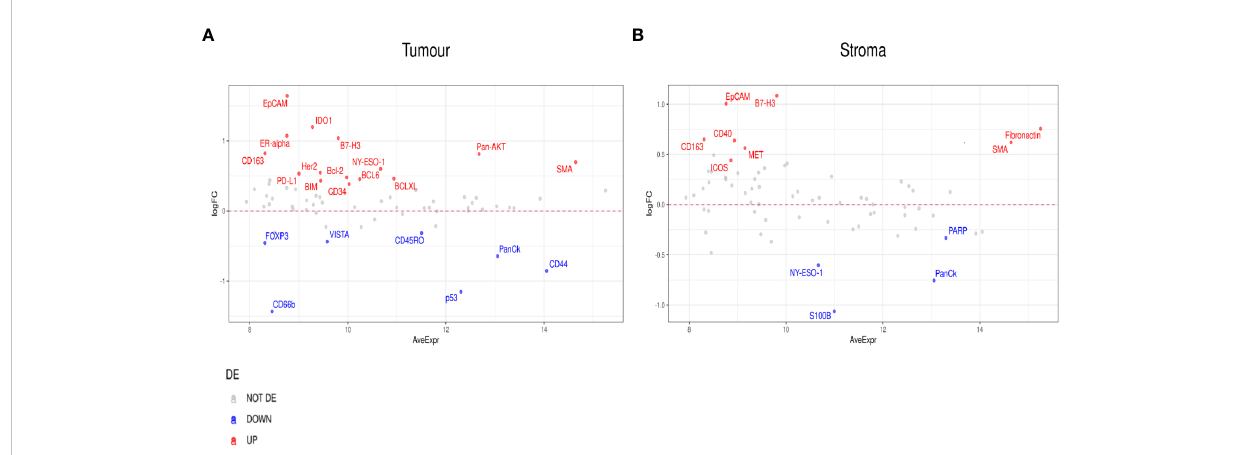
FIGURE 3 Differential protein expression between patient responders (n=9) and non-responders (n=8). (A, B) MA plots of Mean Expression (AveExpr) vs fold change (logFC) visualizing expression of protein biomarkers in responders compared to non-responders for either (A) tumor samples or (B) stroma samples. Colors denote not differentially expressed markers (gray), signi fi cantly up- (red) and down-regulated (blue) markers based on false discovery rate (FDR) < 0.05 after multiple comparison testing.